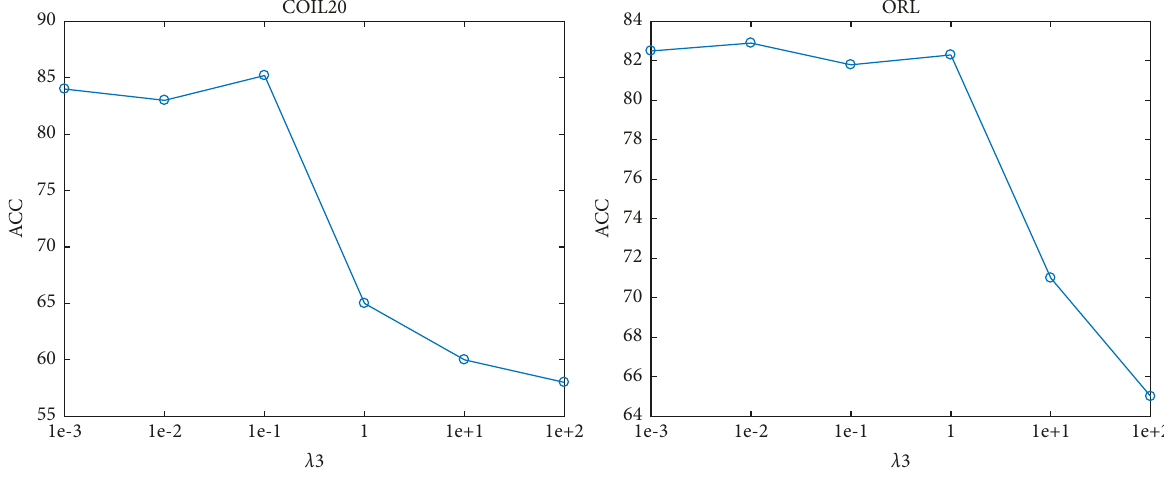
Figure 5: The parameter study of λ